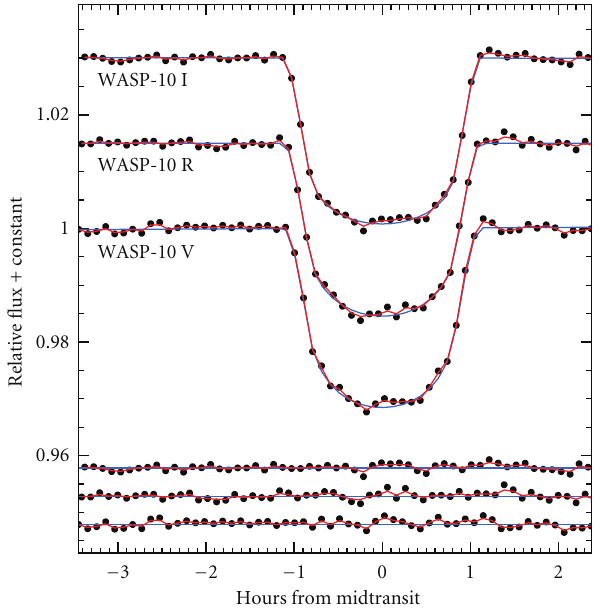
Figure 2: A transit of WASP-10b collected in three filters using OPTIC on UH 2.2m telescope via a filter flipping technique (Section 3.1). Blue curves represent the model light curve while red curves are modified with the derived red